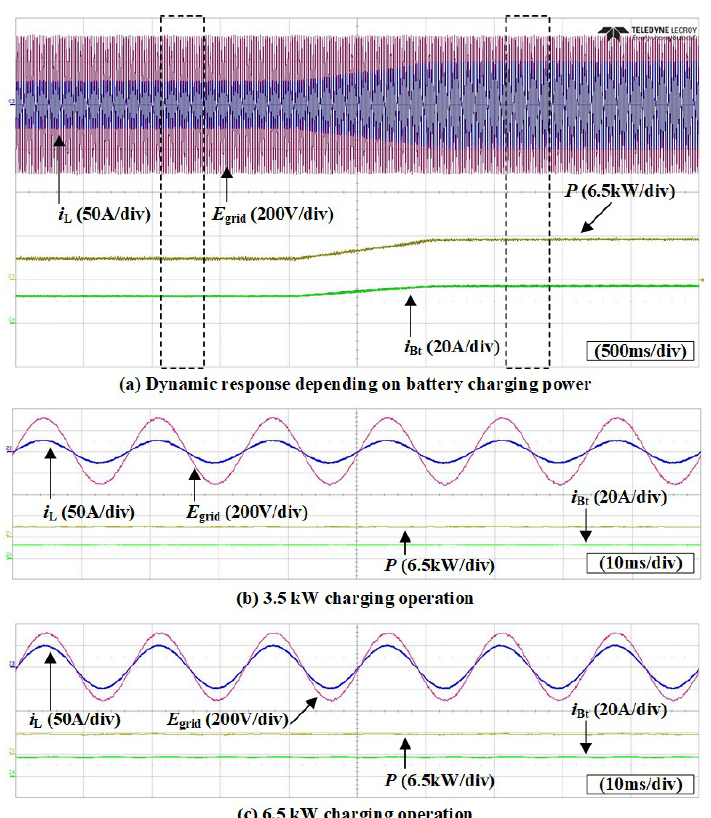
Figure 14. Experimental results of active power and battery current controllers: ( a ) Variation of the charging power from 3.5 to 6.5 kW, ( b ) P = 3.5 kW, ( c ) P = 6.5 kW.